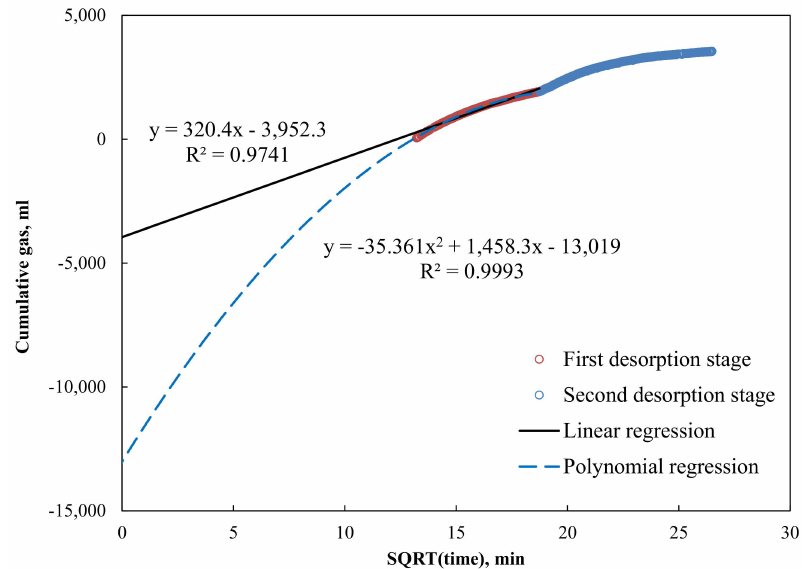
Figure 4. The results of a canister test of a shale core sample from the Longmaxi Formation from Fuling shale gas field in the Sichuan Basin. Desorption is divided into two stages: the first stage is at 53 ◦ C and lasts for 3 h, and the second stage is at 110 ◦ C and lasts until the end of the test. The volume of lost gas is determined by extrapolating the first-stage measurements to “time zero” by linear or polynomial regression. The volumes of lost gas are 3.95 L and 13.02 L,